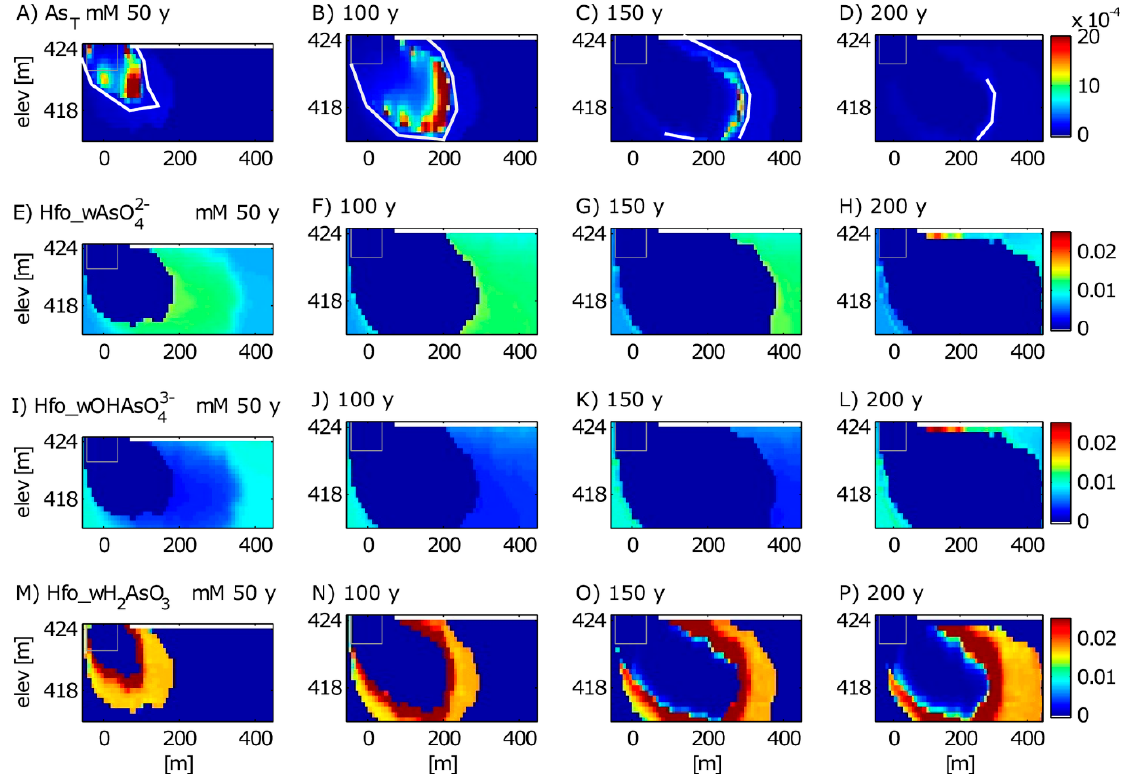
Figure 7. Model simulation results for several As species for the time periods of 50 years (2029), 100 years (2079), 150 years (2129), and 200 years (2179) after the spill. Modeled species include dissolved As ( A – D ) and sorbed species Hfo_wAsO 42 − ( E – H ), Hfo_wOHAsO 43 − ( I – L ), and Hfo_wH 2 AsO 3 ( M – P ). Hfo_wH 2 AsO 4 , Hfo_wHAsO 4 − are omitted because they had negligible concentrations throughout the model. The white line in the dissolved As plots represents the simulated 10 µg/L front. The gray rectangle is the reference for the extent of the oil body. Top boundary is the water table.